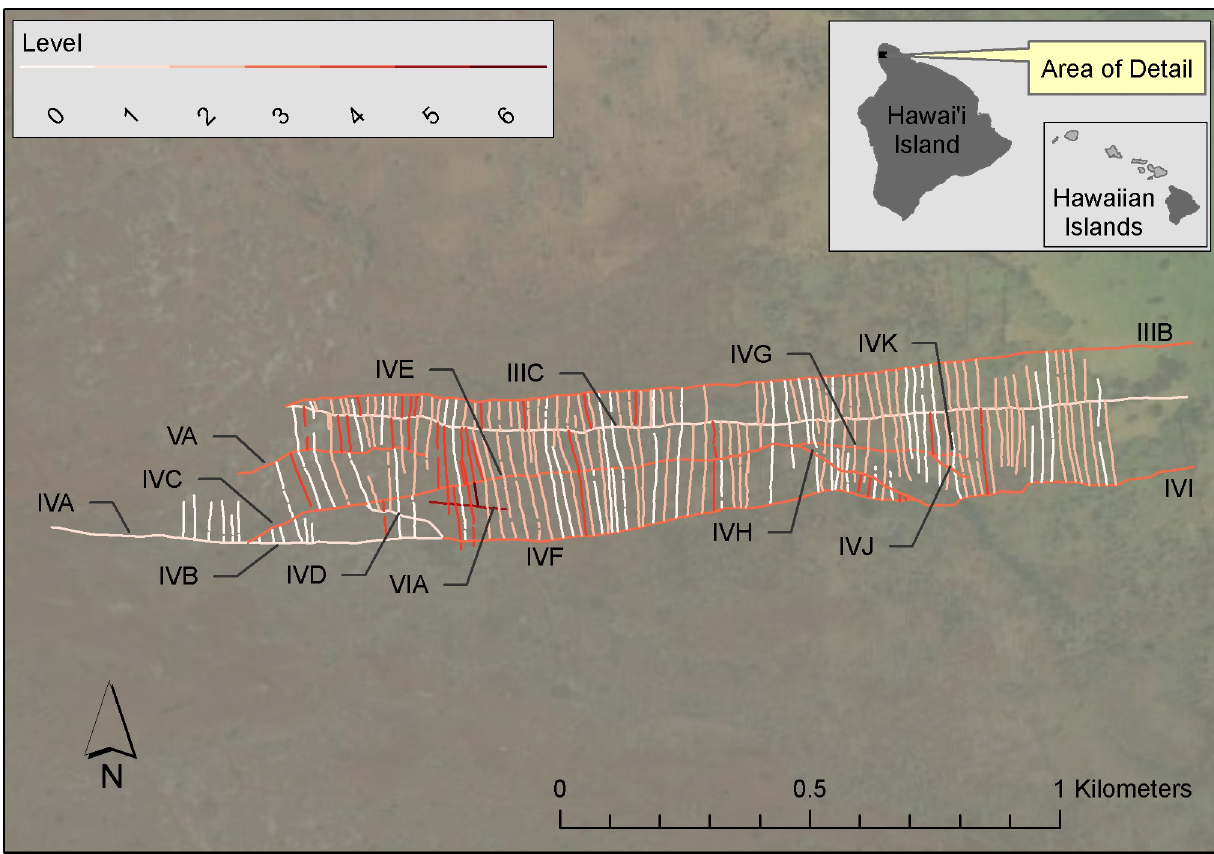
Figure 9. Level assignments in the Lapakahi detailed study area. The trails are labeled. See File S1 for a map of features that includes agricultural wall labels. See Table S9 in File S3 for the model of relative chronological relationships used to create the map. A picture of the directed graph of the relative chronological relationships in the Lapakahi detailed study area is included as Figure S2.